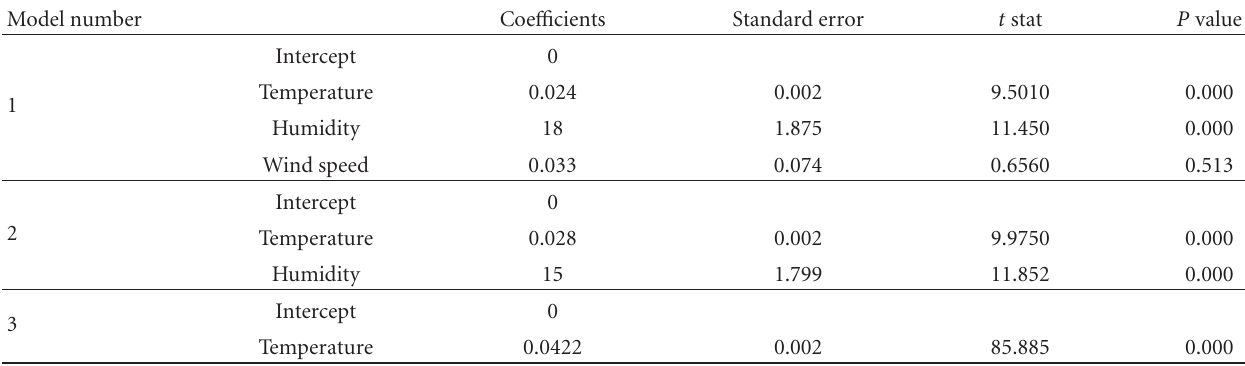
Table 5: Regression results for the suggested models fitted using monthly average meteorological data for Kuwait from 1993 to 2006 (calibration